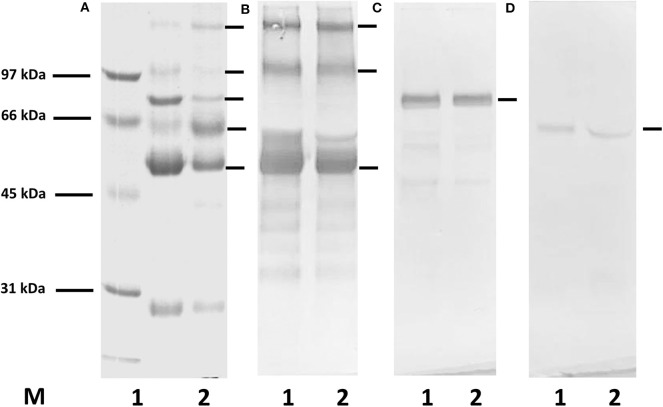
SDS-gel electrophoresis and Western blotting for the demonstration of proteins in the immunoglobulin fractions isolated by Melon IgG Spin purification kit and ammonium sulfate (AS) precipitation from a serum of a healthy donor. (A) Coomassie staining, (B–D) Western blotting with anti-human HRP-conjugated antibodies: (B) anti-human IgG, (C) anti-human IgM, (D) anti-human IgA antibodies; M, molecular weight marker; lane 1, immunoglobulin purified from serum using Melon IgG purification kit; lane 2, AS precipitated proteins. In both fractions only proteins related to immunoglobulins can be observed.